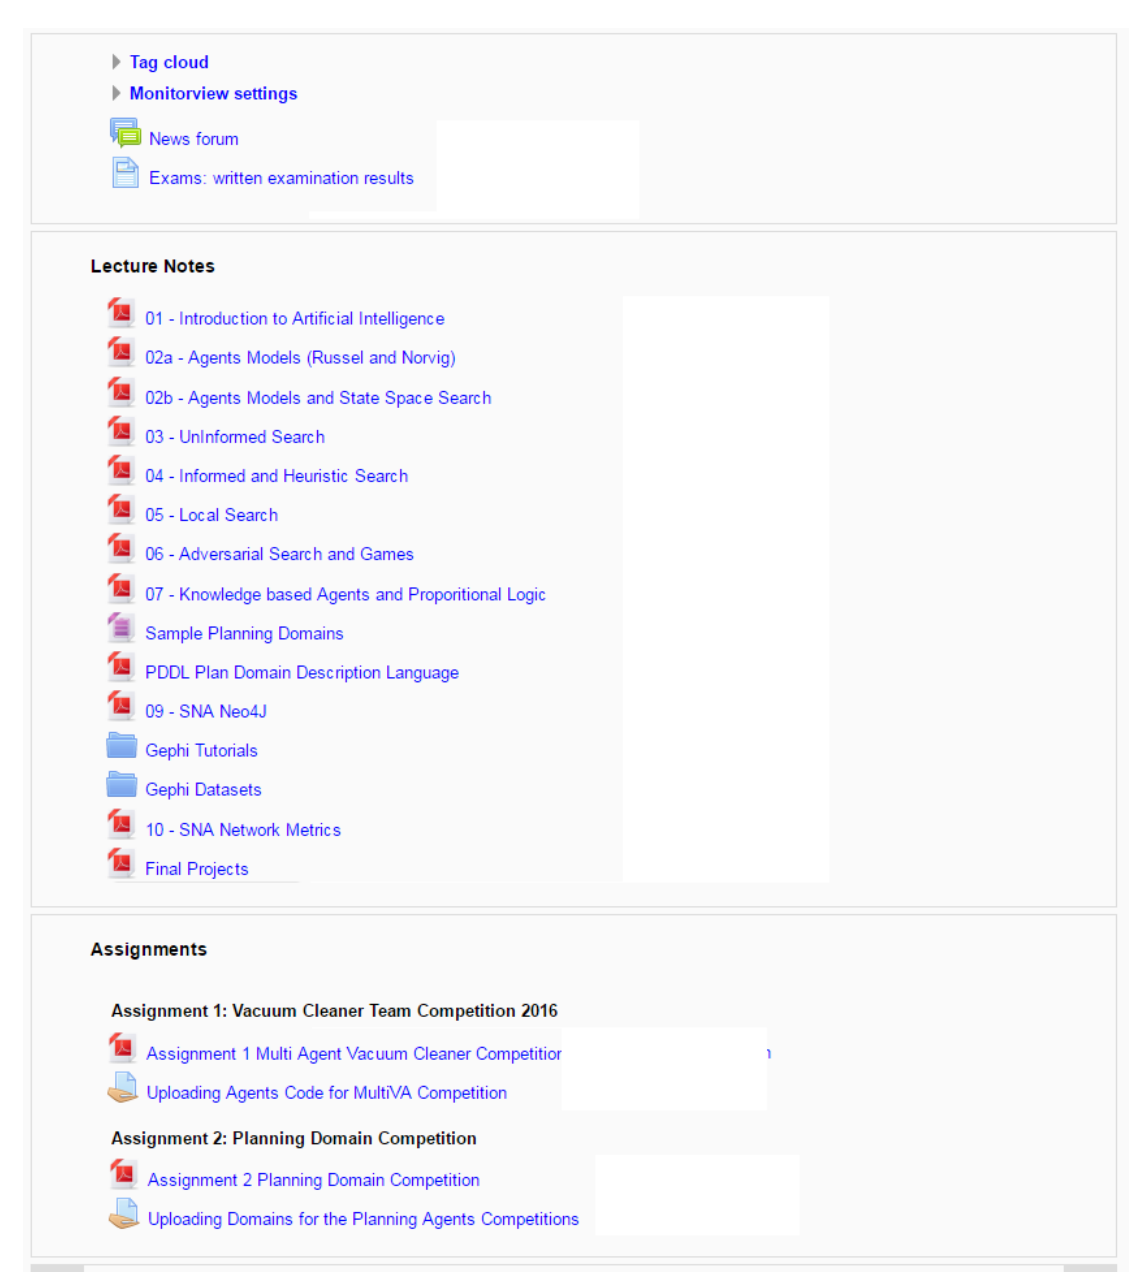
Figure 5. Standard course view with no